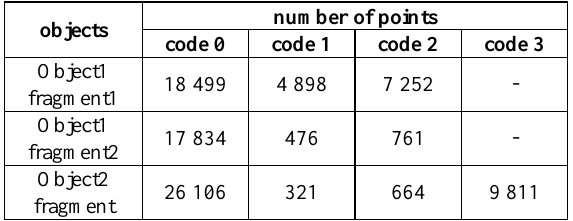
Table 3. The characteristic of the dataset after OptD for objects